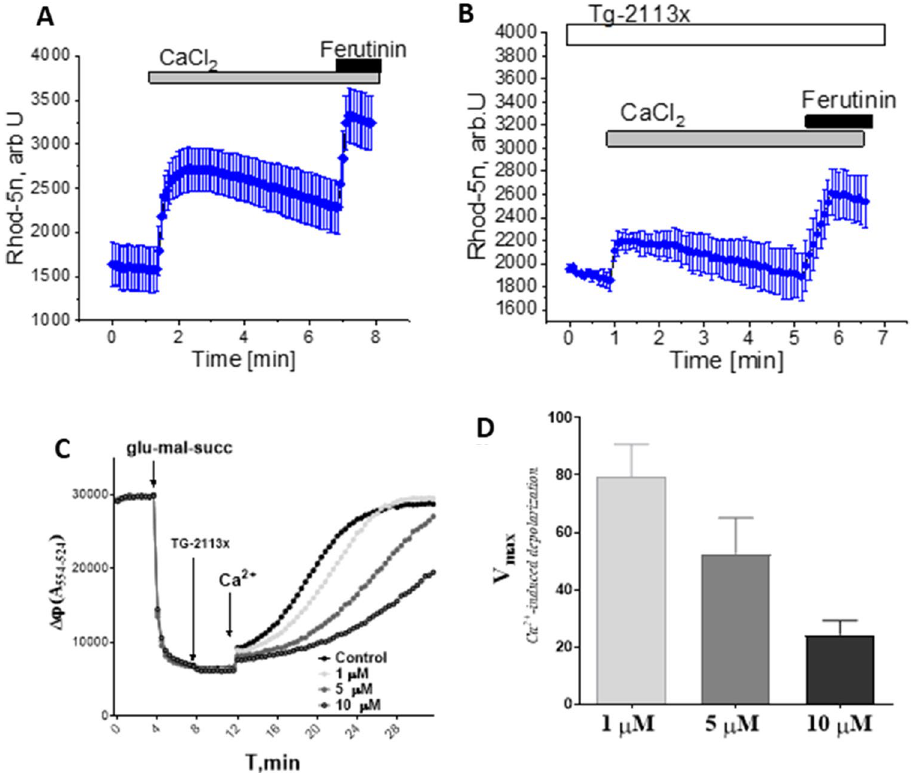
Figure 6. Effect of Tg-2113x on permeabilized cells and isolated mitochondria: application of 100 nM–5 µM calcium to mitochondria of permeabilized neurons induced a rise in [Ca 2+ ] m in control ( A , n = 5 experiments), but not in 0.5 µM Tg-2113x ( B , n = 4 experiments)-treated permeabilized neurons. Ferutinin at the end of the experiment confirms that mitochondria are still intact; ( C ) typical isolated mitochondria potential estimation experiment, ( D ) mitochondrial membrane potential changes after calcium addition as the maximum rate of change in fluorescence normalized between control probe and rate of change in fluorescence before calcium